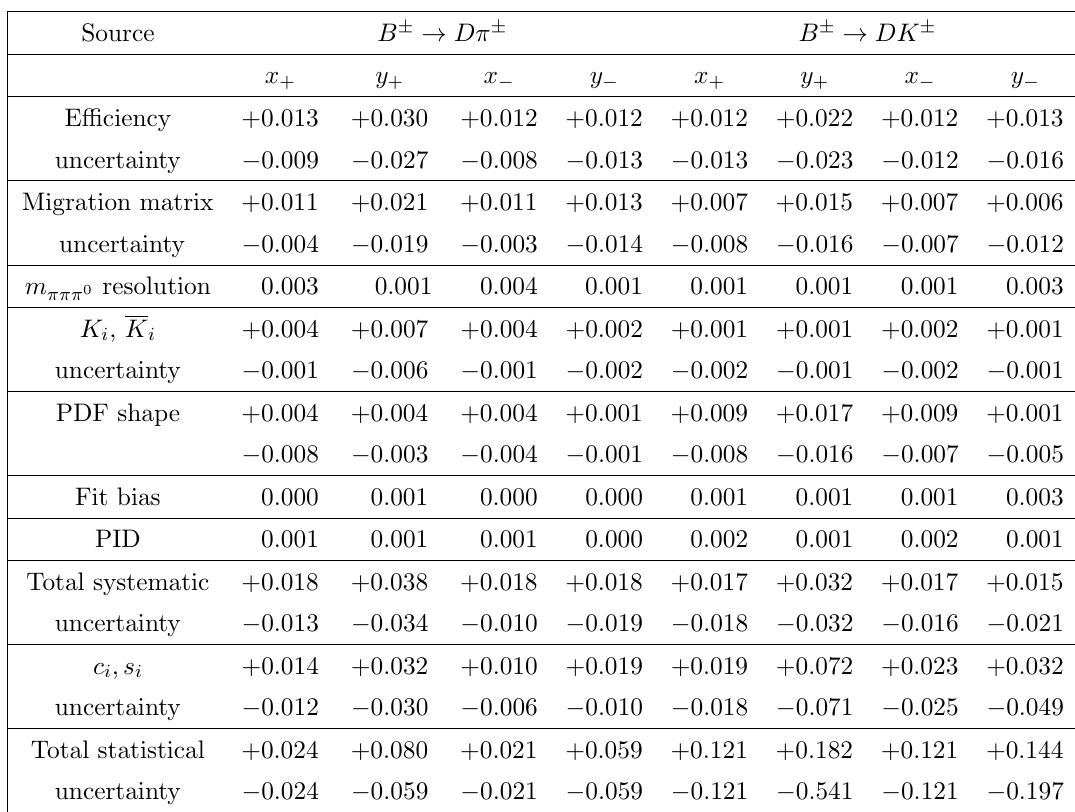
Table 9 . Systematic uncertainties from various sources in B (cid:6) ! D(cid:25) (cid:6) and B (cid:6) ! DK (cid:6) data